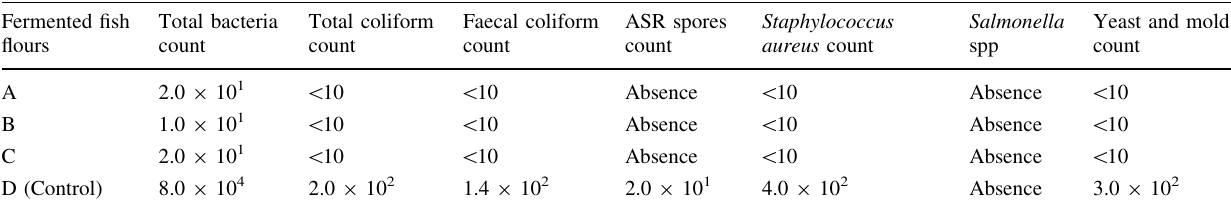
Table 4 Microbiological characteristics of different types of fermented fish flours investigated Fermented fish